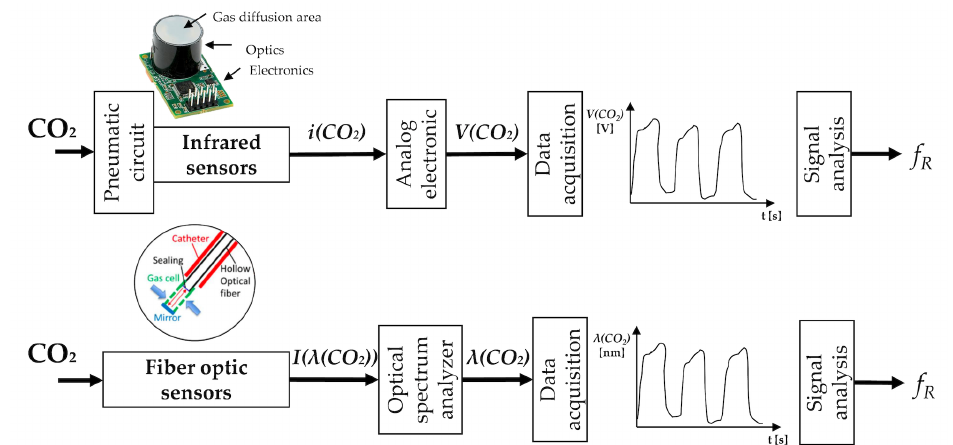
Figure 6. CO 2 sensors: the main elements composing the measuring chain (sensor, analog electronics, data acquisition, post-processing or signal analysis stage) to estimate f R . Analog electronic stages vary between different sensors since the output quantities are different. i ( CO 2 ) , I ( λ ( CO 2 )) are current and light intensity changes caused by the CO 2 , respectively. V ( CO 2 ) is the voltage output. The scheme of fiber-optic sensors is adapted from